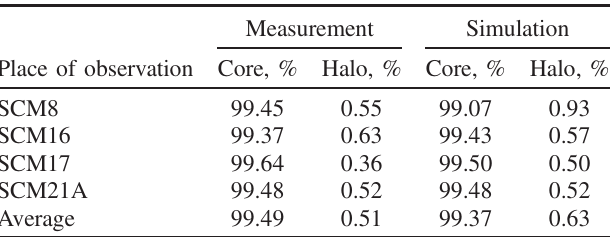
OLGA TANAKA et TABLE VIII. Population of particles at the core and the halo in the measurements and the simulations. Measurement Simulation Place of observation Core, % Halo, % Core, % Halo, %